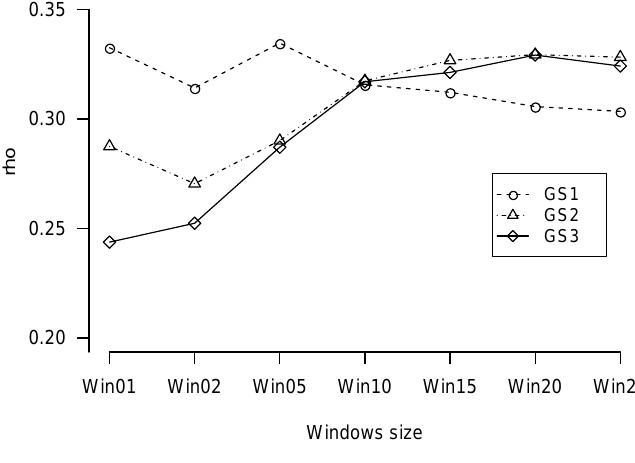
Figure 2: Results for differently sized window models across the three gold standards. The models rely on content